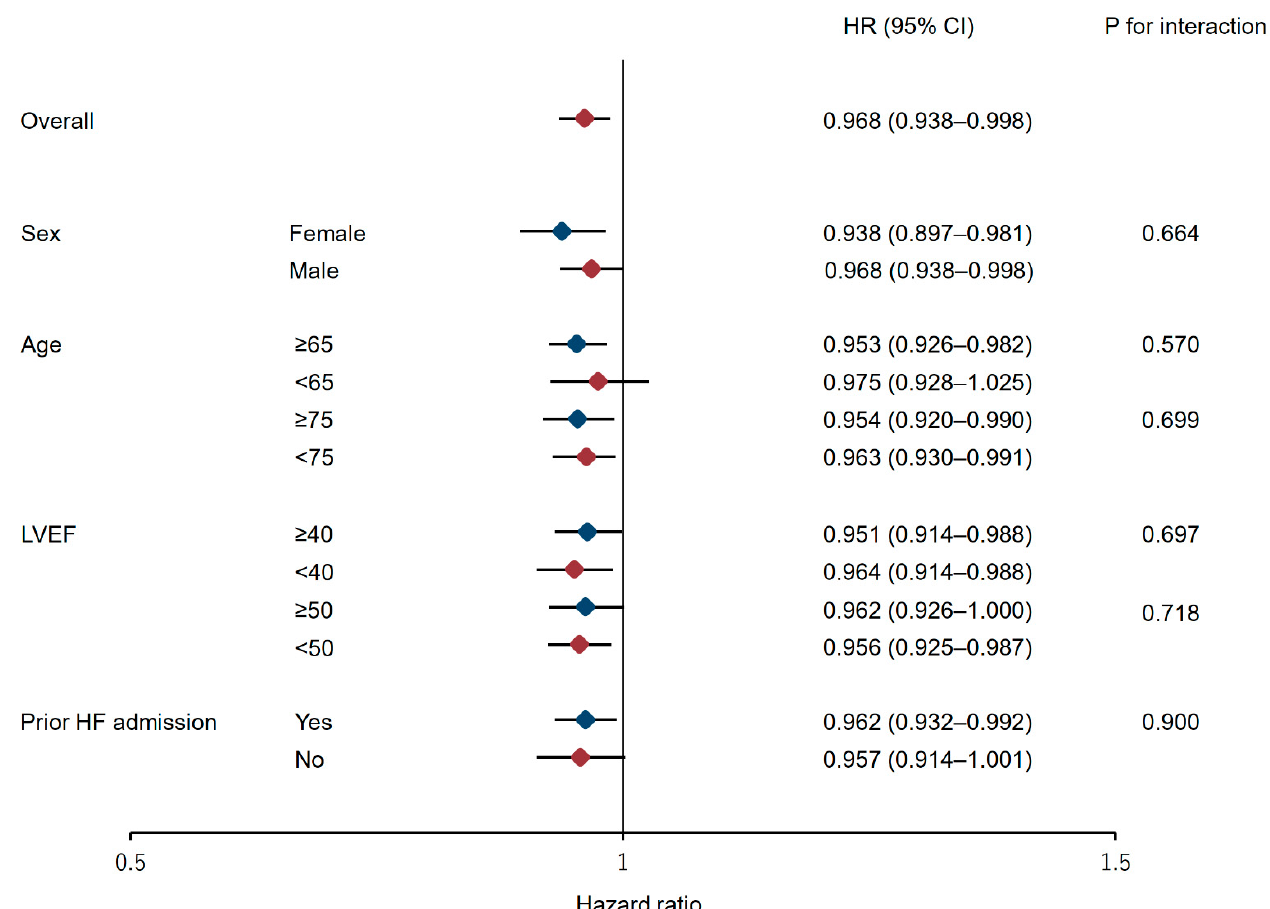
Figure 5. Forest plots of subgroup analyses of the associations between the FAI and all-cause mor-